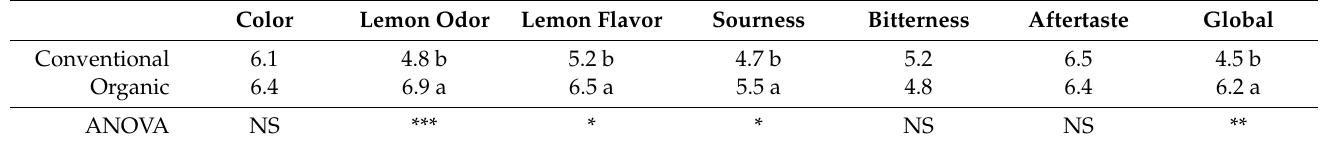
Table 7. Sensory affective test on conventional and organic lemon juice. Color Lemon Odor Lemon Flavor Sourness Bitterness Aftertaste Global Conventional 6.1